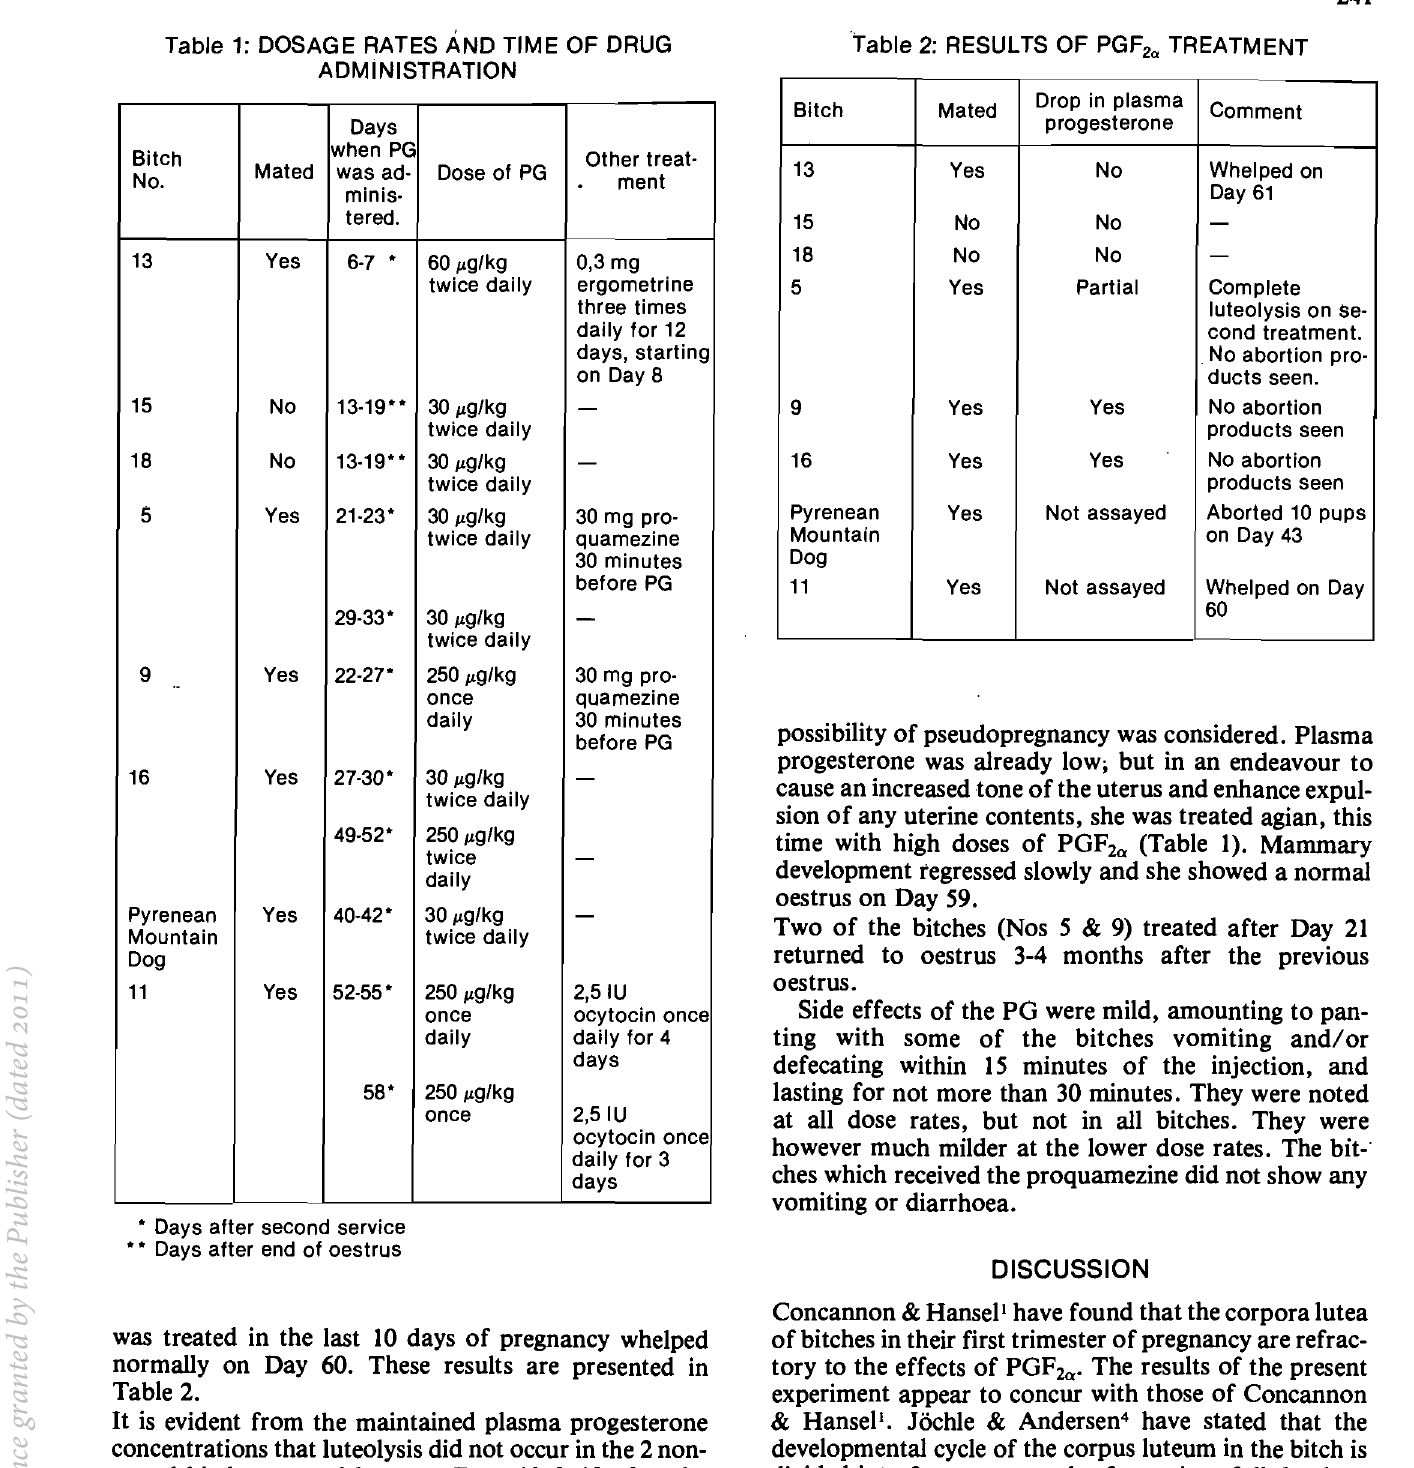
Table 1: DOSAGE RATES AND TIME OF DRUG ADMINISTRATION